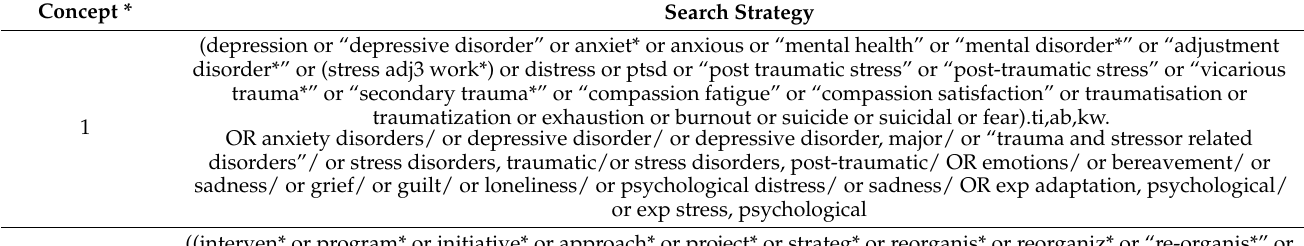
Table A1. Medline search strategy combining concepts 1, 2, 3 and